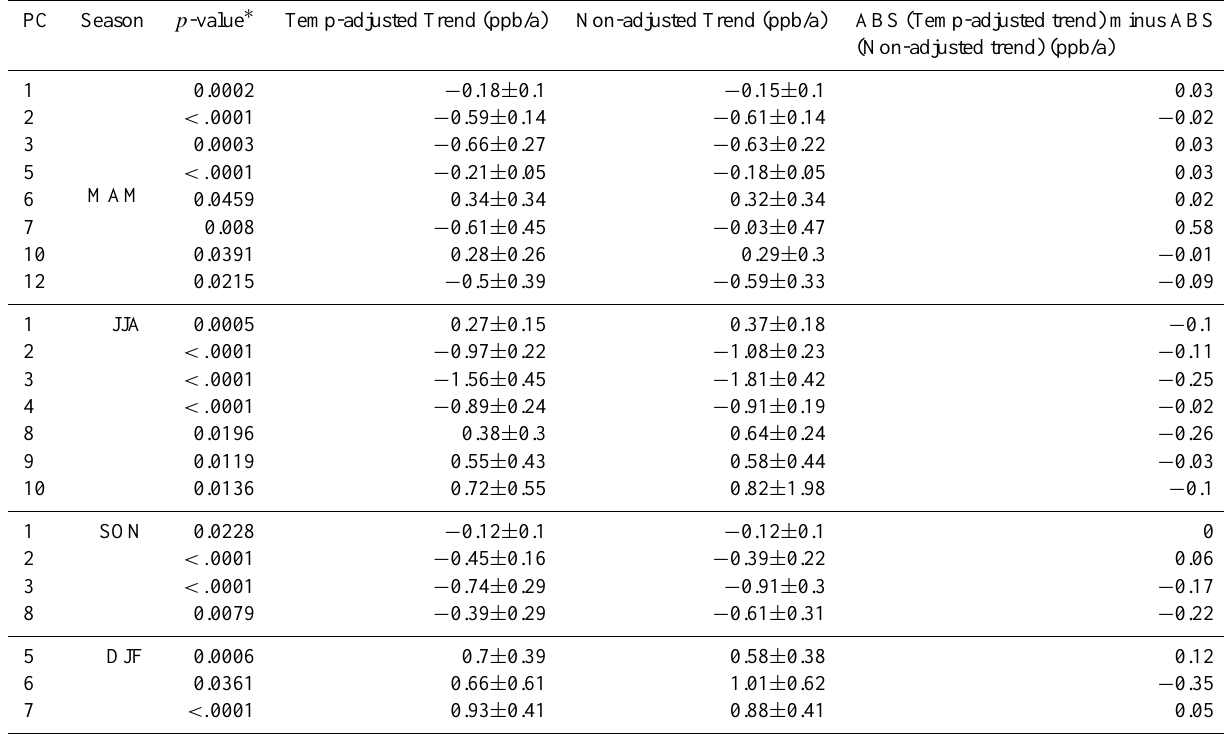
Table 2. Decadal baseline ozone trends modelled by GLMM using daytime (12:00 – 18:00 LST) average ozone mixing ratios from 1997 to 2006 by season. Only regions with significant trends (p-value less than 0.05) are shown. *p-values are shown for temperature-adjusted trends only. The trend results are tabulated inppb per annum. Note that the PC numbers shown in the first column correspond to Fig. 7a and change from season to season. “ABS” stands for the absolute value of the trend.